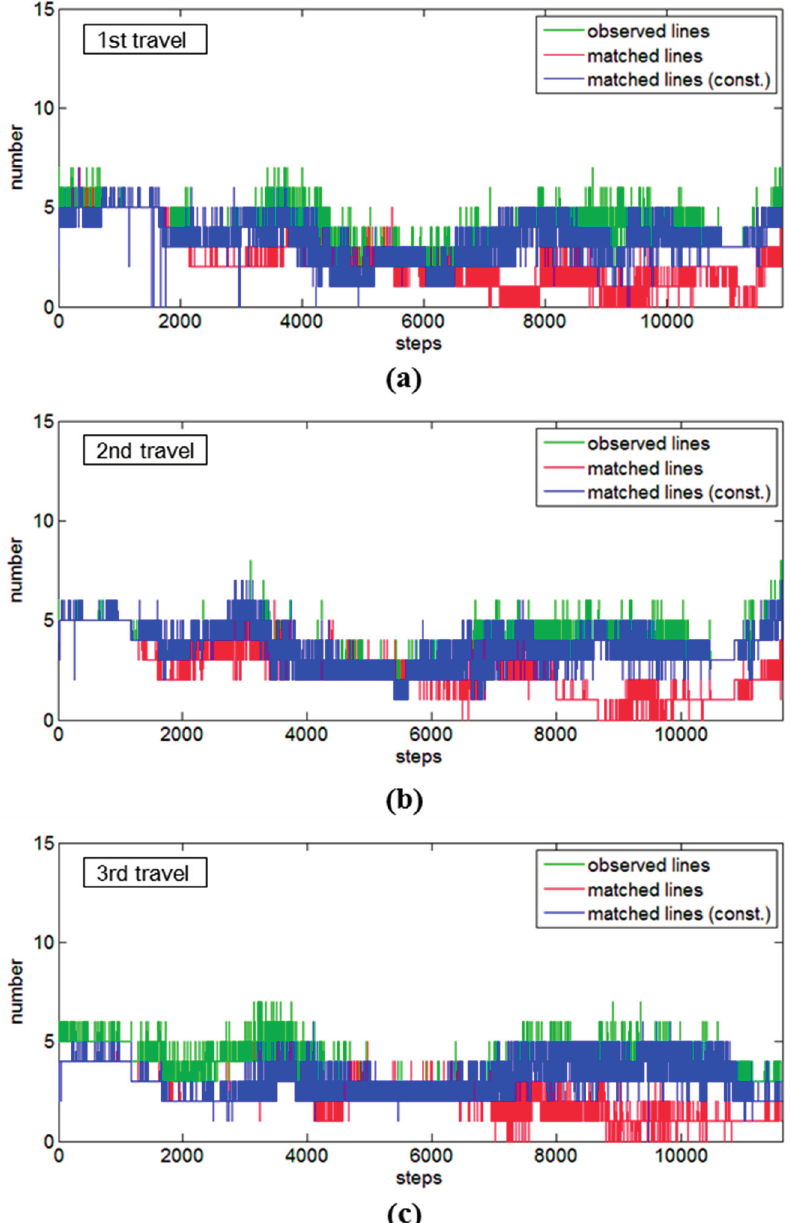
Figure 12. Comparisons of data association results for the corridor test: ( a ) first travel; ( b ) second travel; and ( c ) third